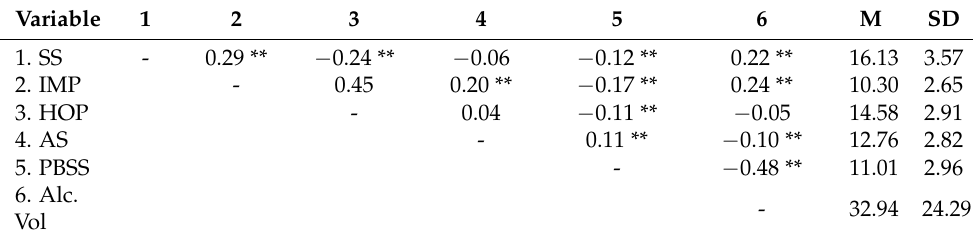
Table 1. Study 1: Means, standard deviations, and Pearson correlations between personality traits, protective behavioral strategies, and alcohol